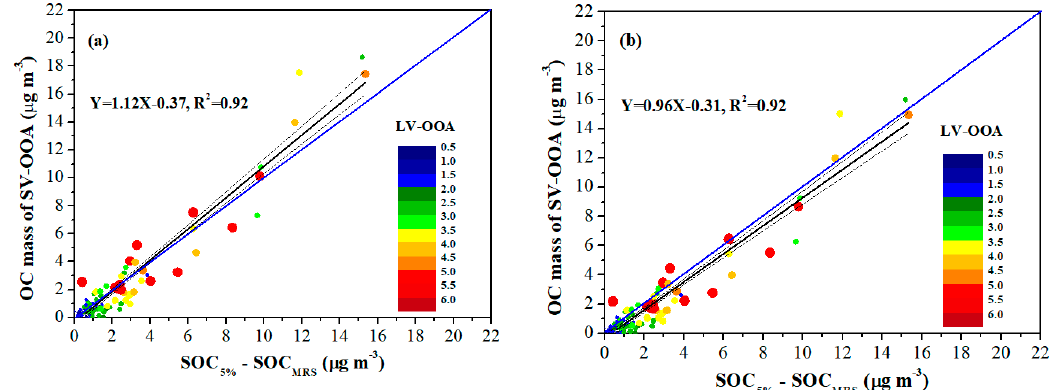
Figure 8. Correlations between the differences in SOC concentrations derived via the 5% percentile and MRS methods and the estimated OC mass of the SV-OOA using a conversion factor of OA/OC = 1.8 ( a ) and OA/OC = 2.1 ( b ), as a function of the low-volatility oxygenated organic aerosol (LV-OOA) (colored scale) in Athens. The blue line corresponds to “1:1”.